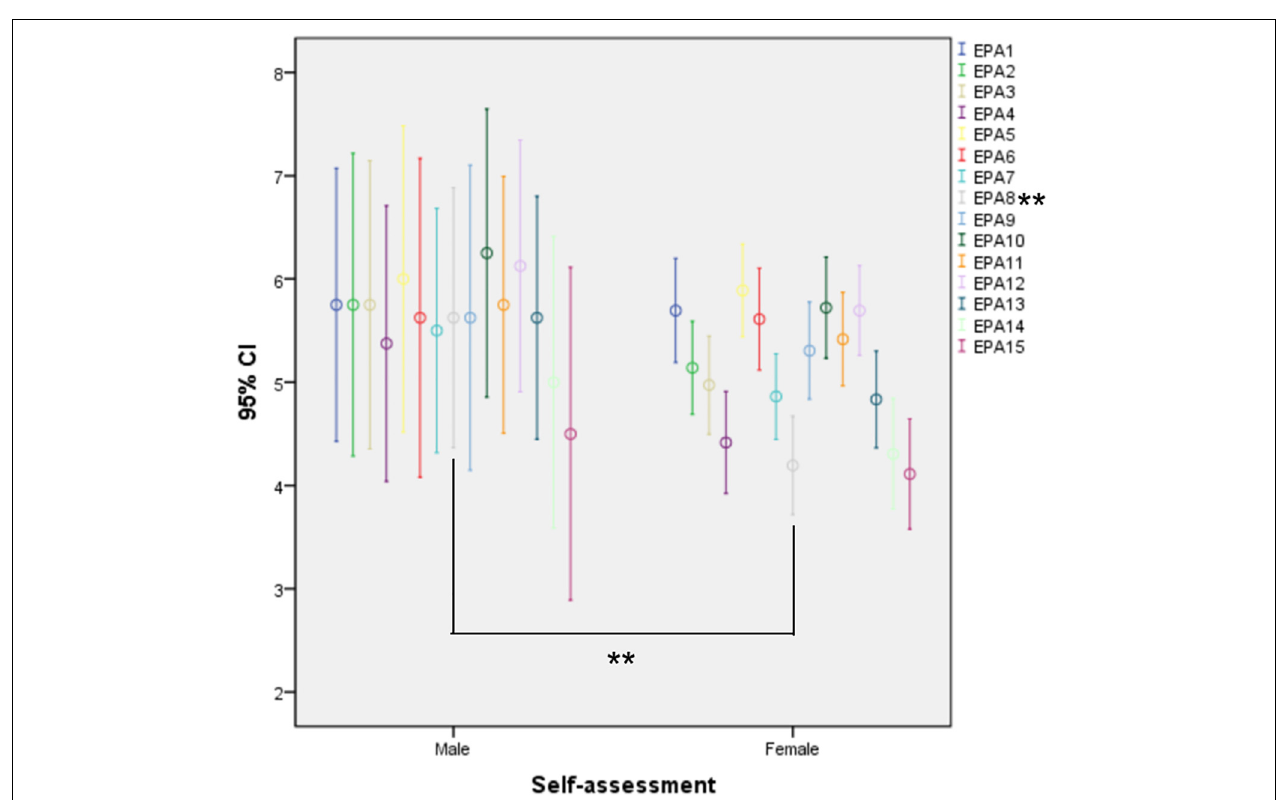
FIGURE 2 | Error bar chart of self-assessment between genders. The edges of each bar stand for the 95% CI of scores in subgroups. **EPA8: p = 0.019, p <